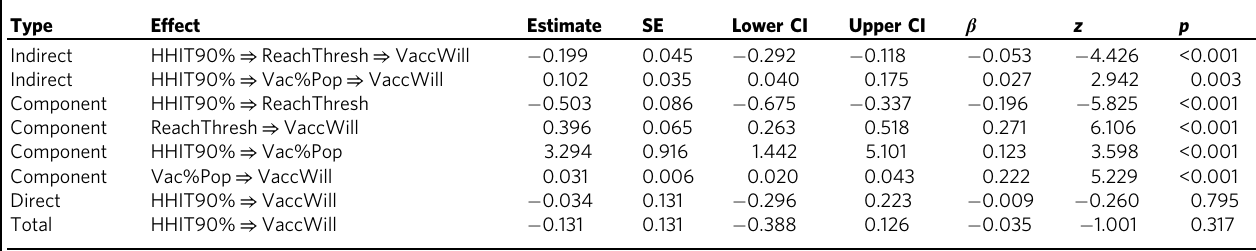
Table 3 Results of mediation analysis of the effects of two beliefs on the willingness to vaccinate now, through the manipulation of presenting the high or the low threshold as